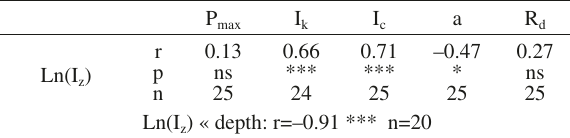
Table 3. – Correlations between the photosynthetic parameters, dark respiration and the daily highest PFD arriving at each depth.